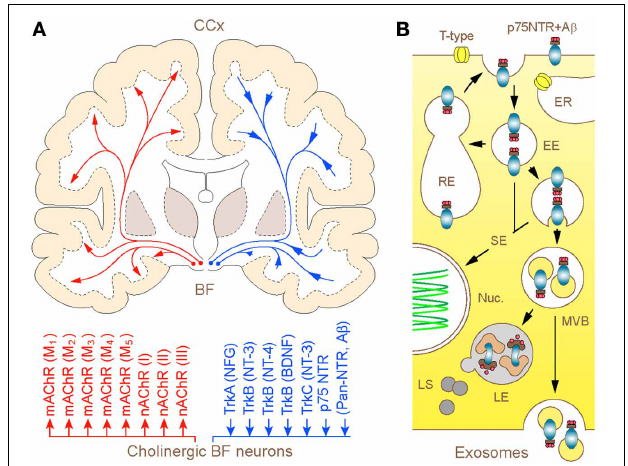
FIGURE 1 | (A) Schematic illustration of the human BF cholinergic projections with modulator and neurotrophic mechanisms: coronal brain section. Long-range cholinergic axons and collaterals supply the entire cerebral mantle with acetylcholine (upper), which via muscarinic (mAChR1–5) and nicotinic (nAChRI-III) cholinergic receptors regulate a wide range of cortical processes and functions (lower). The diffuse projections through retrograde axonal transport channel back to the basal forebrain cholinergic neurons signaling endosomes and organelles, which carry trophic factors and other ligands bound to trkA-C and p75NTR. The homeostatic significance of p75NTR-mediated uptake of A β and its degradation in lysosomes of basal forebrain cholinergic neurons is discussed. (B) Graphical illustration of 3 possible intra-cellular routes taken by p75NTR (and A β ) carrying endosomes. After internalization via clathrin-dependent and -independent processes, a fraction of p75NTR (and A β ) loaded endosomes is recycled back to the plasma membrane, whereas the rest is sorted to signaling endosomes and multivesicular bodies (MVBs). From here, bulk of the cargo is degraded in hybrid MVB—lysosomal compartments, which comprise the primary metabolic hot spots of A β proteolysis (Mullins and Bonifacino, 2001) while a minute fraction escapes from degradation through MVB sorting into exosomes and becomes available for exocytotic released from the cell (Rajendran et al., 2006; Trajkovic et al., 2008). Abbreviations: EE and RE—early and recycling endosomes, respectively; ER—endoplasmic reticulum; SE—signaling endosomes (SE); Nuc.—nucleus; LE and LS—late endosomes and lysosomes,